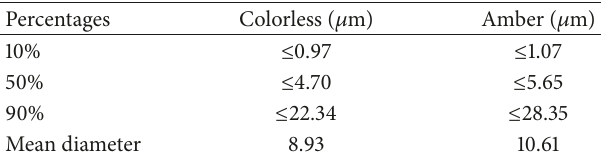
Table 2: Laser particle size distribution of colorless and amber glass microparticles.